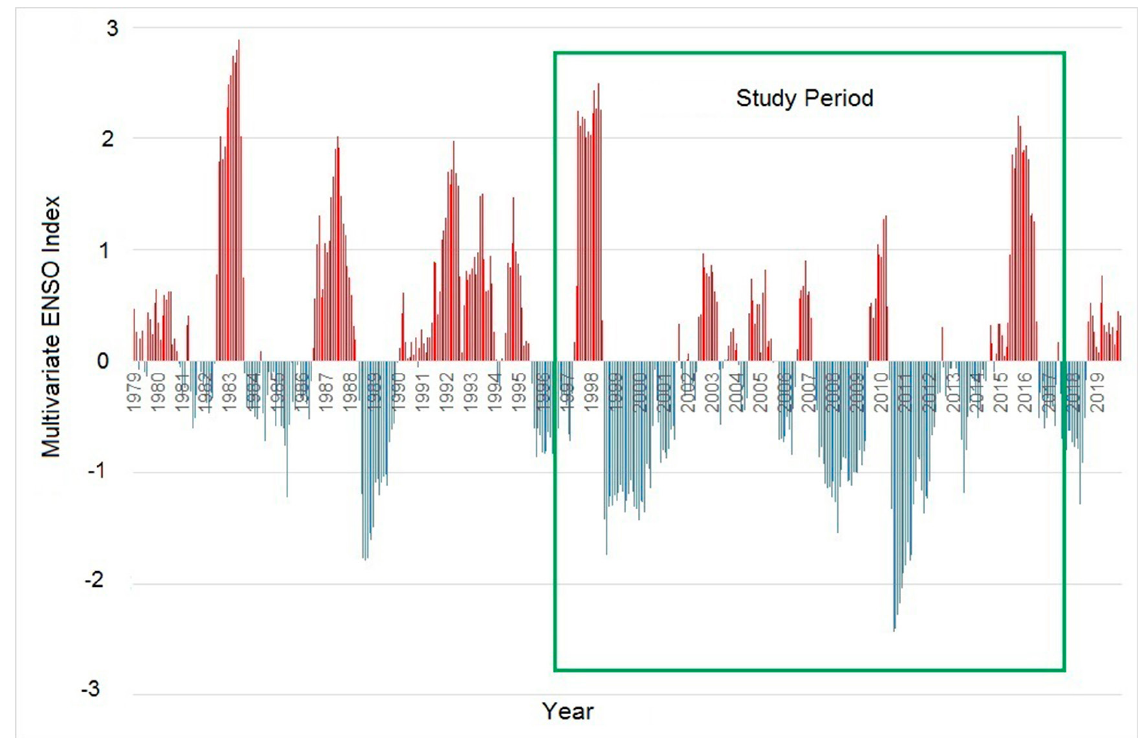
Fig. 9. – Period of study of El Niño and La Niña events. Red bars, Niño; Blue bars, Table 3. – Years and intensity of El Niño and La Niña. Based on Oceanic Niño Index. Jan Null, CCM. Updated in Dec.-Jan.-Feb. 2020. https://ggweather.com/enso/oni.htm El Niño